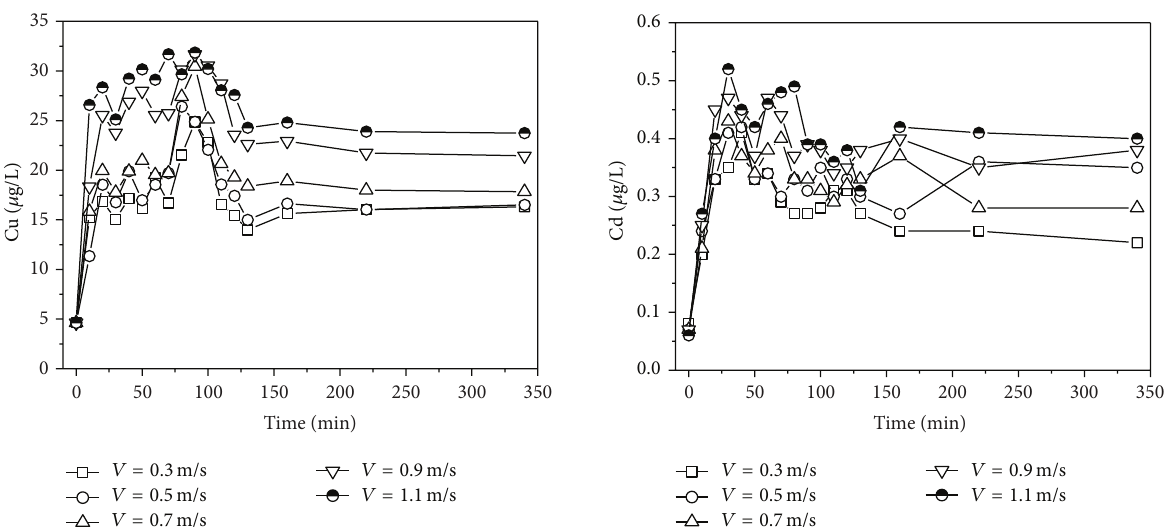
Figure 9: The concentration of Cu and Cd in the overlying water changed with times.